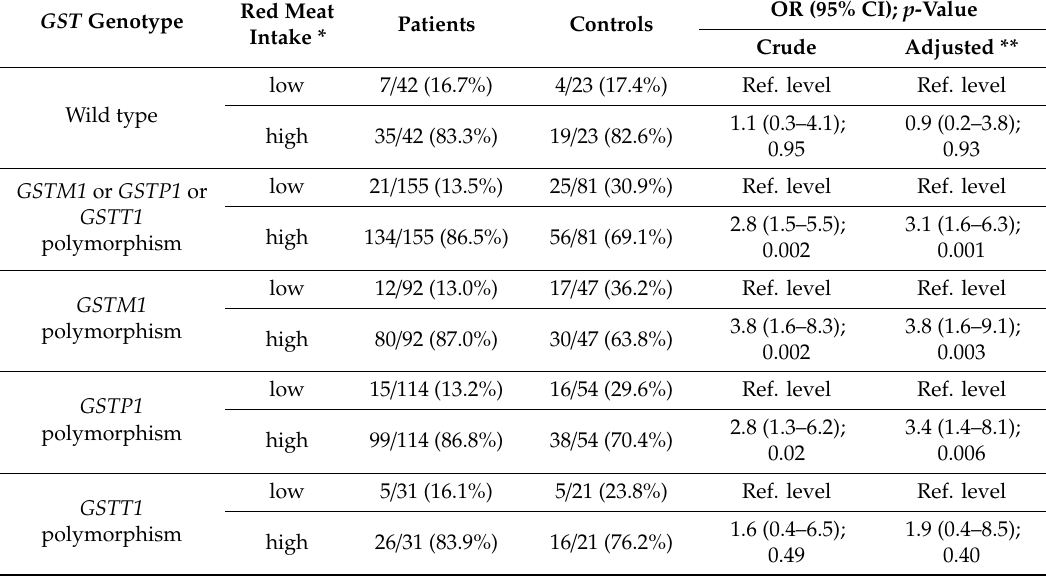
Table 2. Relationship between the frequency of red meat intake and the status of colorectal cancer (CRC) depending on the occurrence of polymorphism in the examined